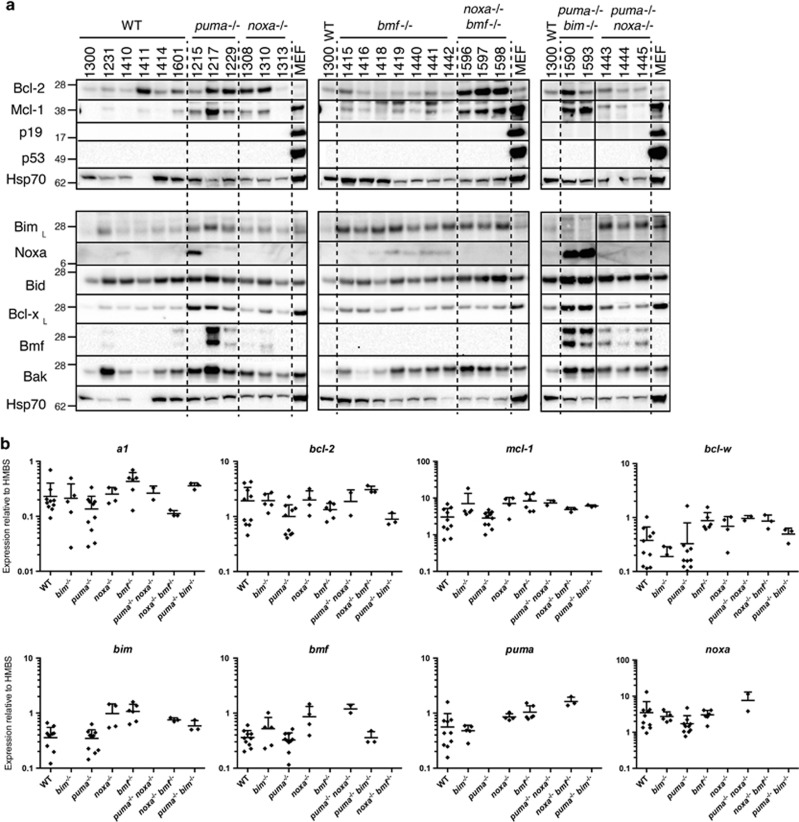
Expression of apoptosis regulatory genes in MLL-AF9 AMLs. (a) Western blot and (b) qPCR analysis of expression of p53, p19Arf and bcl-2 gene family members in bone marrow cells of sick primary MLL-AF9 AML mice (Supplementary Methods). Protein and RNA were prepared from bone marrow taken at autopsy. Panels in a indicate six separate gels, each of which included WT AML #1300, with dotted lines separating different genotypes (the solid line in panel 3 indicates electronic removal of a lane). SV40 transformed mouse embryonic fibroblasts (MEF) served as positive controls for p53 and p19Arf expression; Hsp70 served as a loading control. Molecular weight (kD) markers are indicated. The following AMLs were analyzed by qPCR: WT #1223, 1224, 1155, 1156, 1231, 1232, 1601, 1410, 1411, 1414; bim−/− #1249, 1250, 1213, 1157, 1158; puma−/− #1230, 1214, 1215, 1216, 1217, 1218, 1225, 1226, 1228, 1229; noxa−/− #1259, 1313, 1308, 1310; bmf−/− #1440, 1441, 1442, 1416, 1419, 1418; puma−/−
bim−/− # 1590, 1593; noxa−/−
bmf
−/− #1596; 1597; 1598; puma−/−
noxa−/− #1443; 1444, 1445. qPCR analysis was relative to that of hydroxymethylbilane synthase (HMBS). Error bars indicate S.D. Data for additional Bcl-2 family members is provided in Supplementary Figure S4